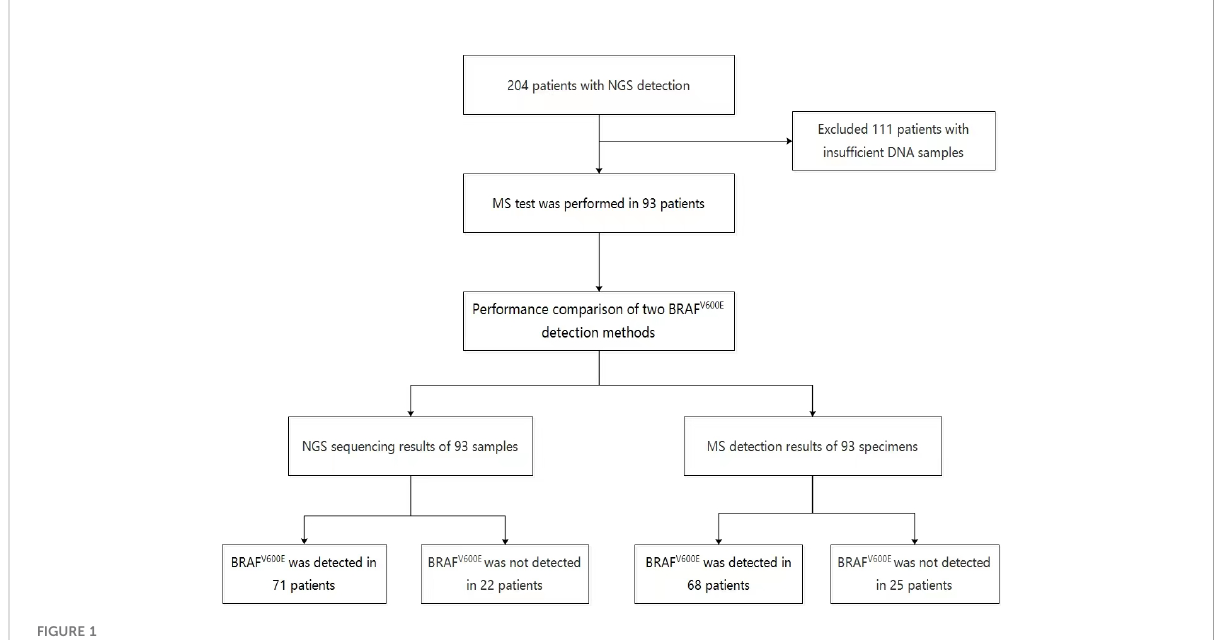
FIGURE 1 Flow chart of the